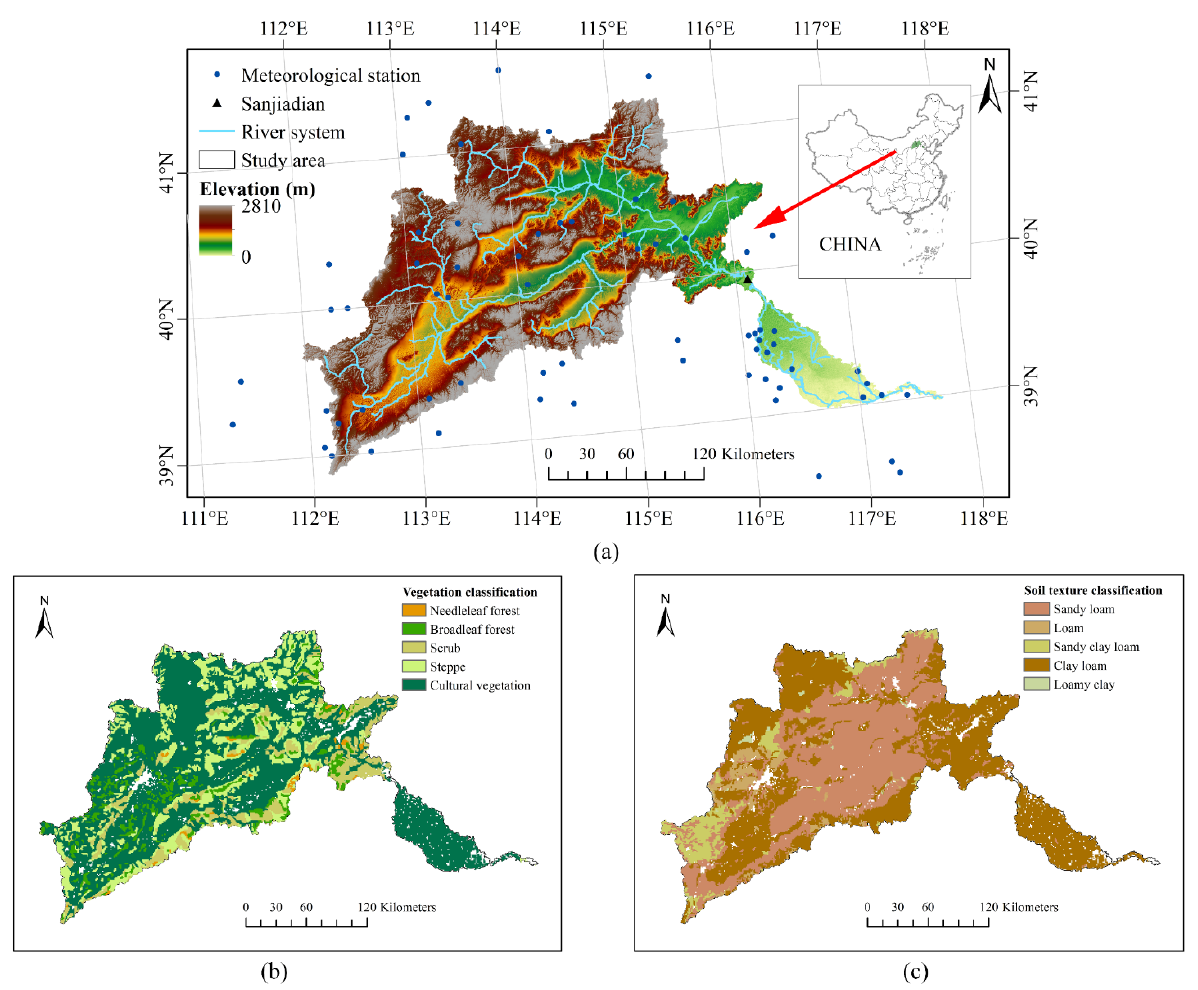
Figure 1. General conditions of the Yongding River watershed, China. ( a ) Geographic location; ( b ) major vegetation types; ( c ) soil texture types. Blank grids in the study area are urban and built-up lands, water bodies, wetlands, or barren areas, which are not included in the research of this paper. The WGS84 geographic coordinate system and Albers projection coordinate system were used. The resolution of ( a ) is 30 m and that of ( b , c ) is 1 km.